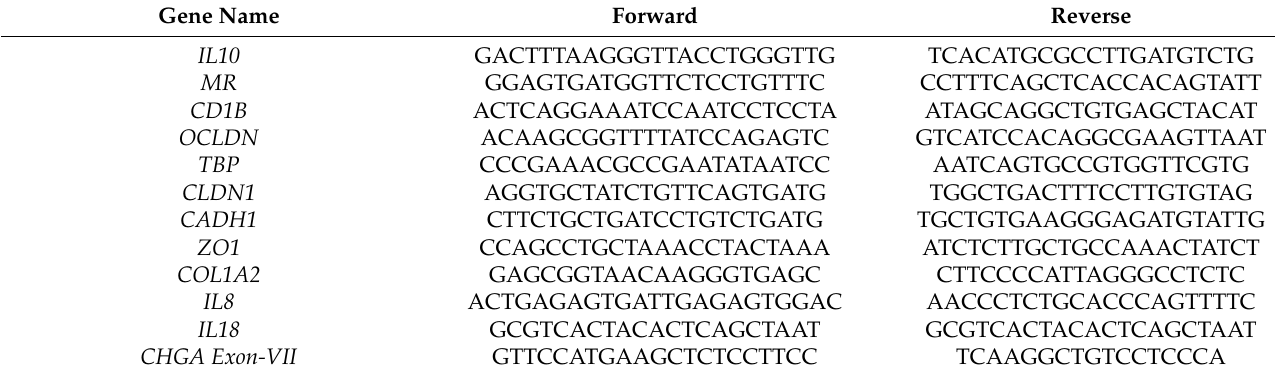
Table 1. Human primer sequences.